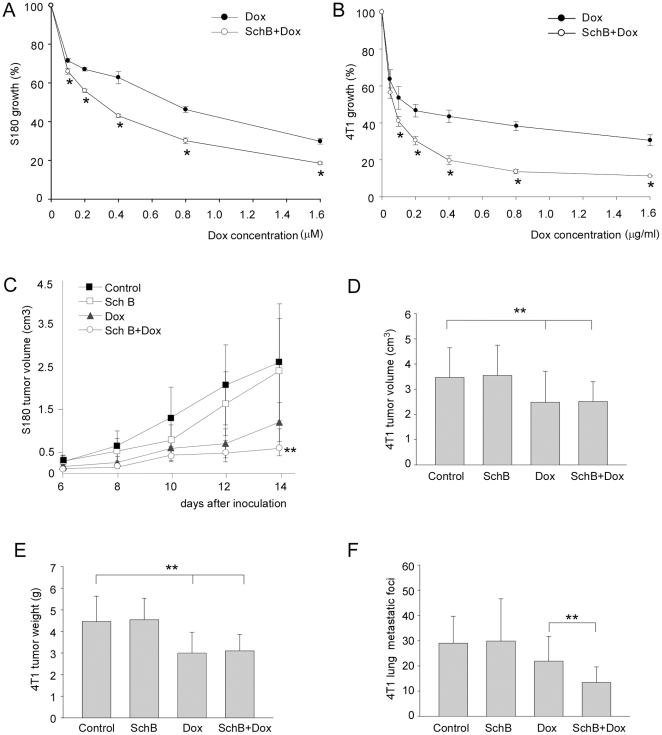
Sch B enhances the anticancer activity of the Dox in vitro and in vivo.A and B, in vitro growth inhibition rates of S180 cells (A) and 4T1 (B) by Dox in the presence or absence of Sch B. The inhibition rate was calculated as the ratio of the treated over the control. *, P<0.05. C–F, in vivo growth inhibition of S180 and 4T1 by Dox with or without Sch B. C, S180 tumor volume, **, P<0.05, Sch B+Dox versus Dox group; D, E, & F, 4T1 tumor volume, tumor weight, and pulmonary metastatic foci in 4T1 mice model (data were collected 28 days after 4T1 cell inoculation). The data were collected **, P<0.05, Dox, Sch B+Dox versus control group; E, 4T1 tumor weight, **, P<0.05, Dox, Sch B+Dox versus control group; F, , **, P<0.05, Sch B+Dox versus Dox group.